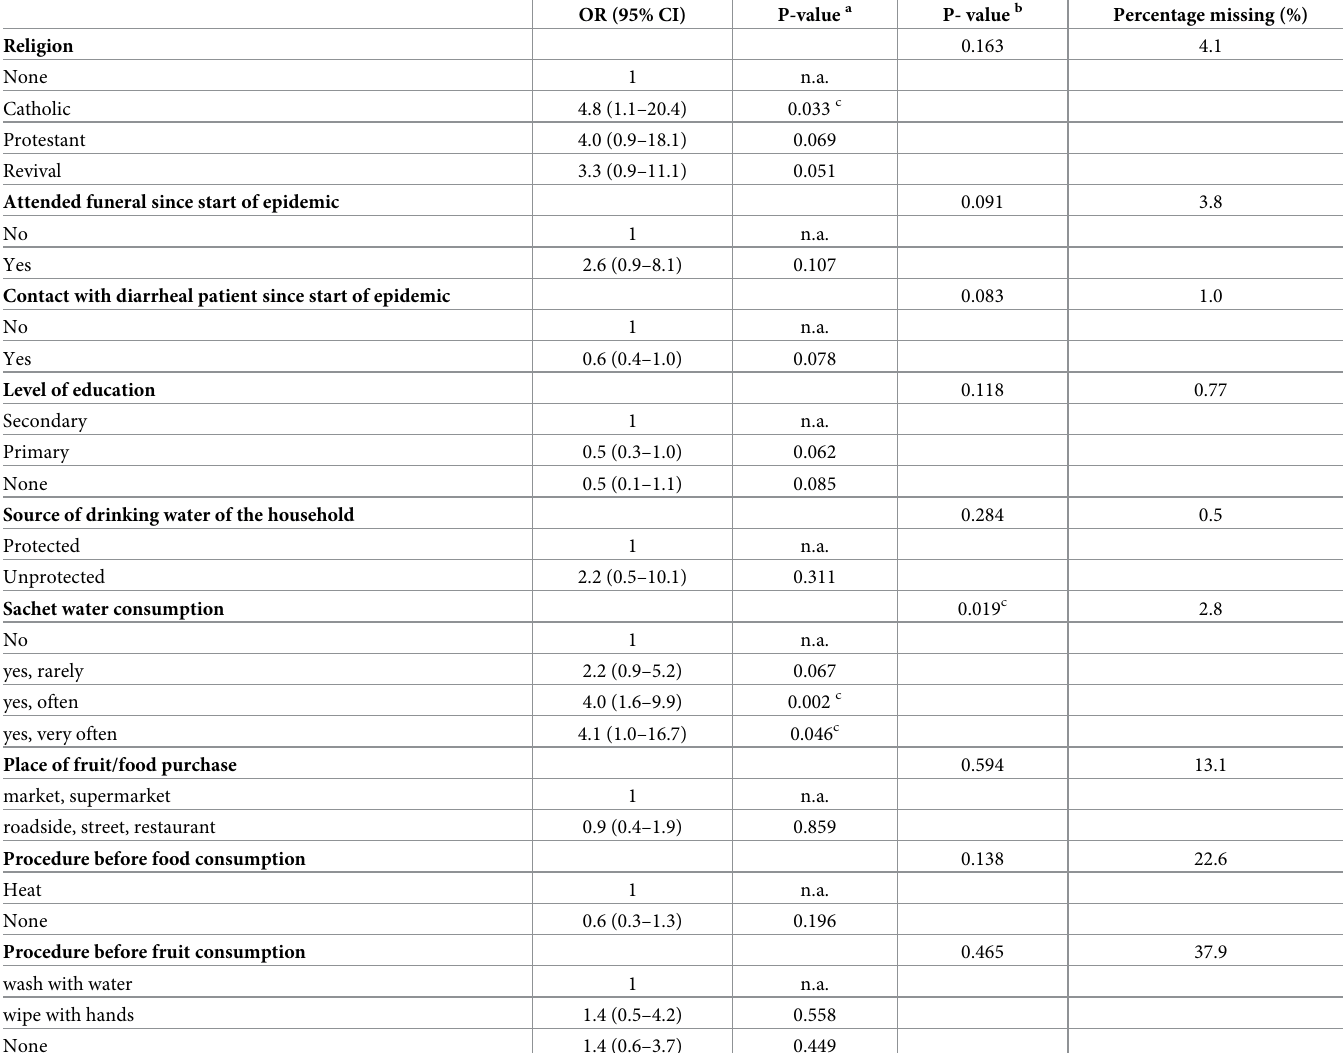
Table 2. Multivariate